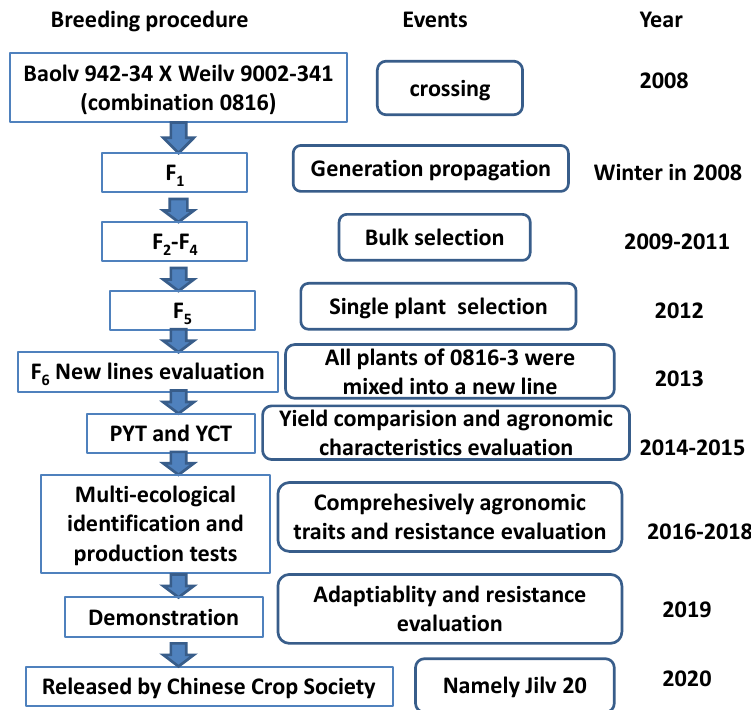
Figure 1. Jilv 20 breeding overview. Notes: This paper mostly focuses on the multi-ecological and production test data.